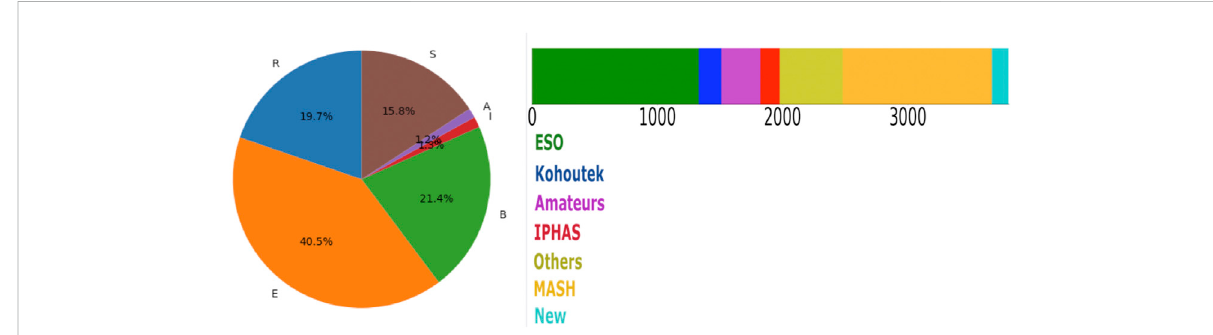
FIGURE 10 Graphical representation of the morphological percentages of Galactic PNe in HASH and where the HASH PNe have originated. On the right handsidebarchartofPNelistingorigin, “ ESO ” referstotheAckeretal.PNecatalogues, “ Kouhoutek ” tothevariousPerekandKohoutekcompilations while the other designations are